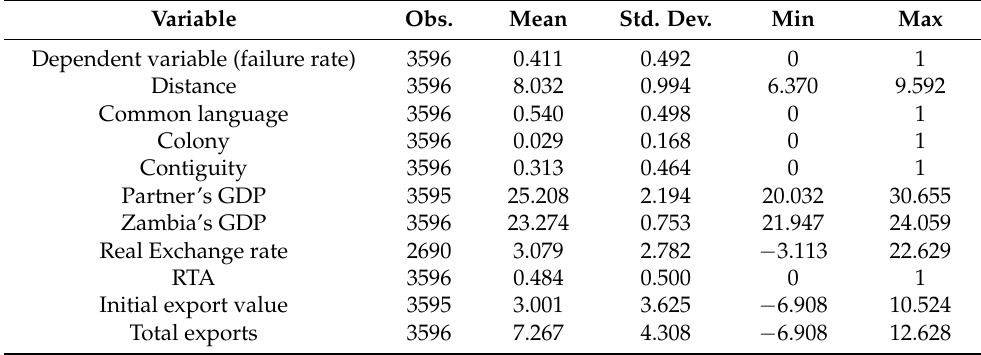
Table A3. Summary of